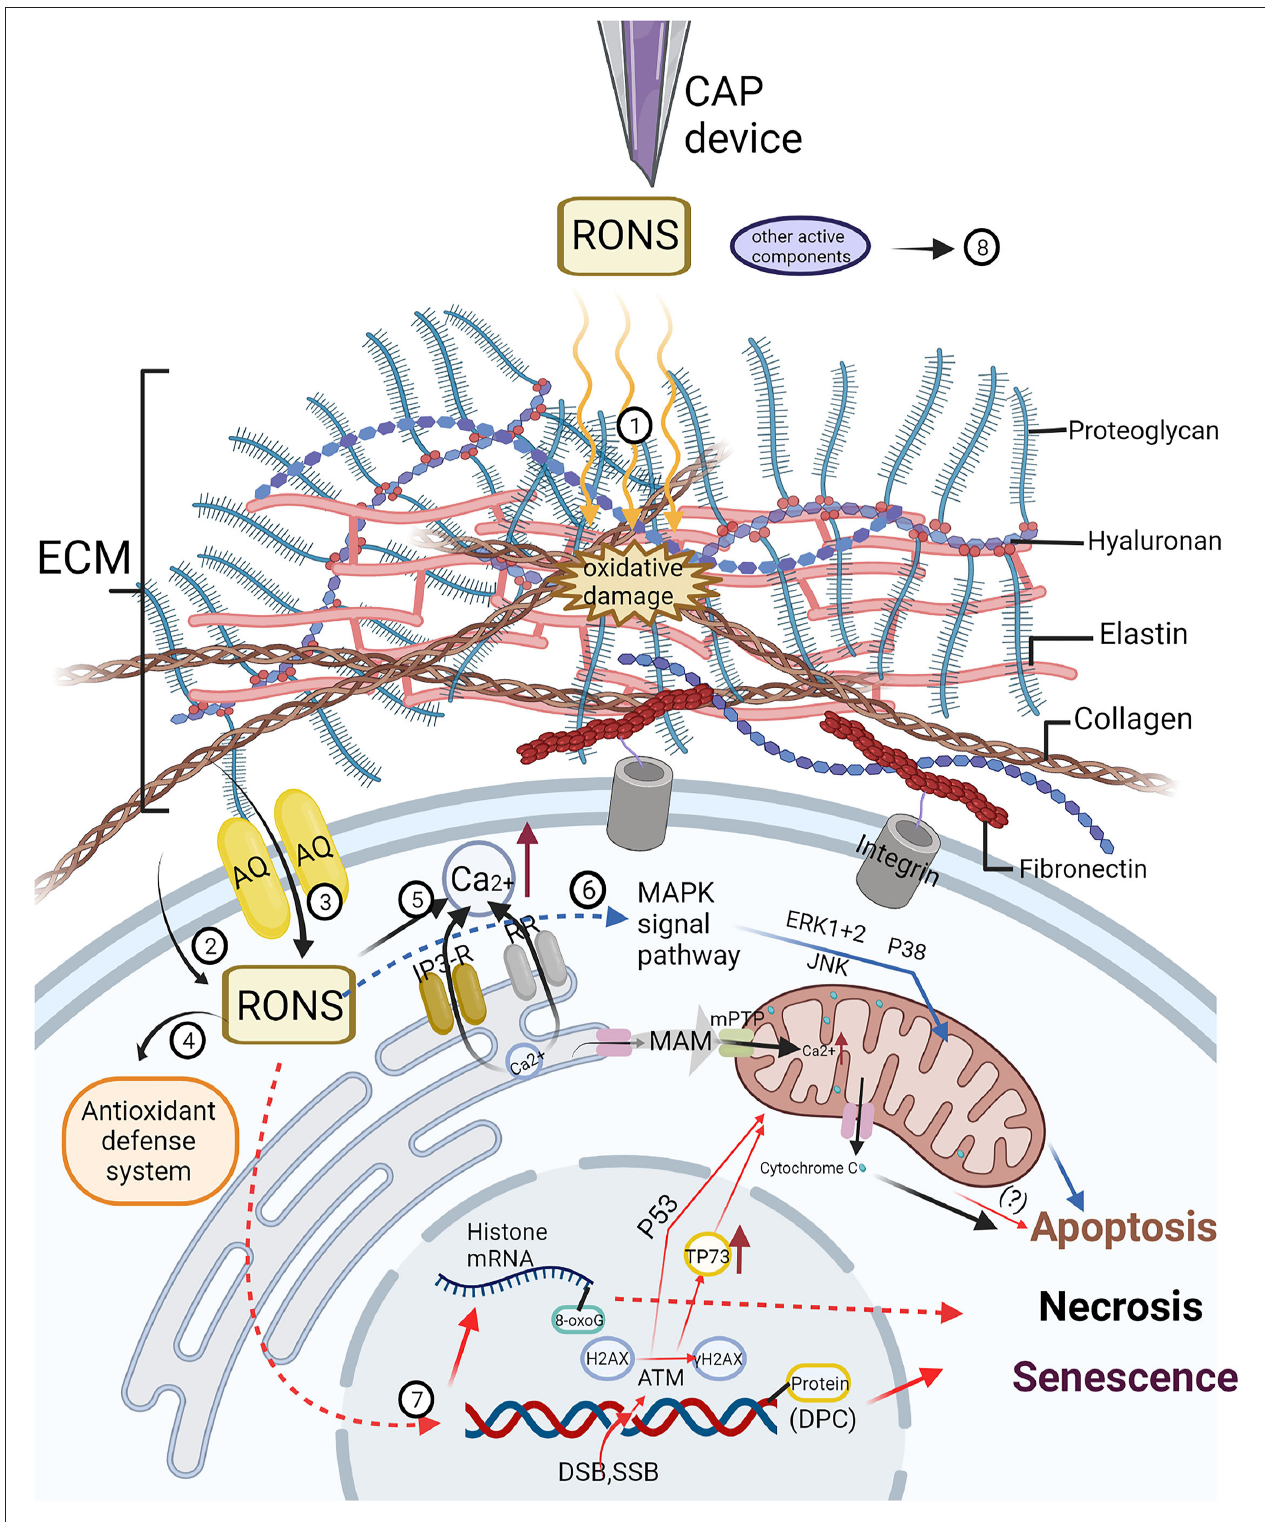
FIGURE 2 | The effect of cold atmospheric plasma (CAP) on extracellular matrix (ECM) and its molecular mechanism on tumor cells have been studied at present. (1) CAP can inhibit tumor progression by oxidizing or destroying the structure of extracellular matrix (ECM), which includes collagen, hyaluronan, fibronectin, integrin and so on. (2) The cholesterol content of tumor cell membrane is lower than that of non-malignant cells, and it is easier for CAP-derived reactive oxygen and nitrogen